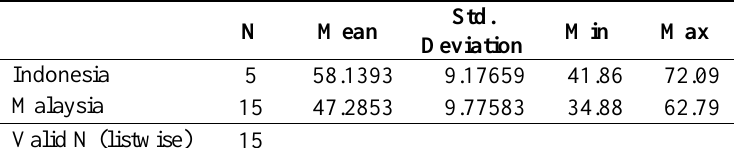
Table 1 Descriptive Statistics Analysis